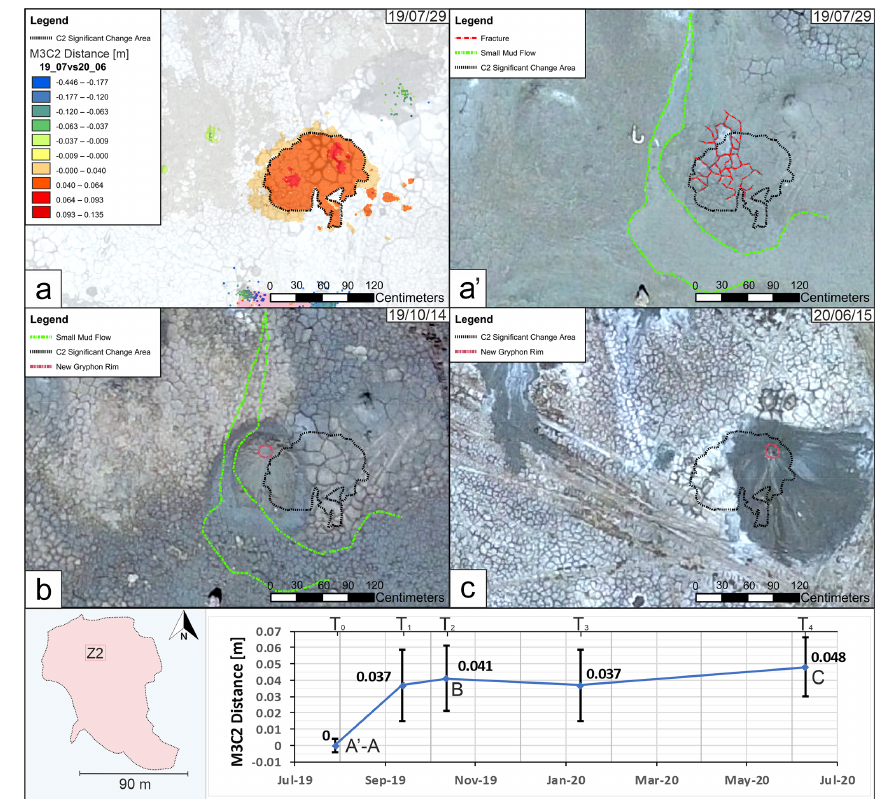
Figure 17. (a) M3C2 distance (29 July 2019 vs. 15 June 2020) of the Z 2; the area used to create the time series is delimited with a dashed line (selected by significant change). (a’) Orthophoto of 29 July 2019, the margin of the deflected flow in green and the radial fractures in red. (b) Orthophoto of 14 October 2019, formation of a new emission gryphon in red and the previous flow in green. (c) Orthophoto of 15 June 2020, formation of a new emission gryphon in red. Below, the time series with upward trend is shown. The reference system is WGS 84/UTM zone